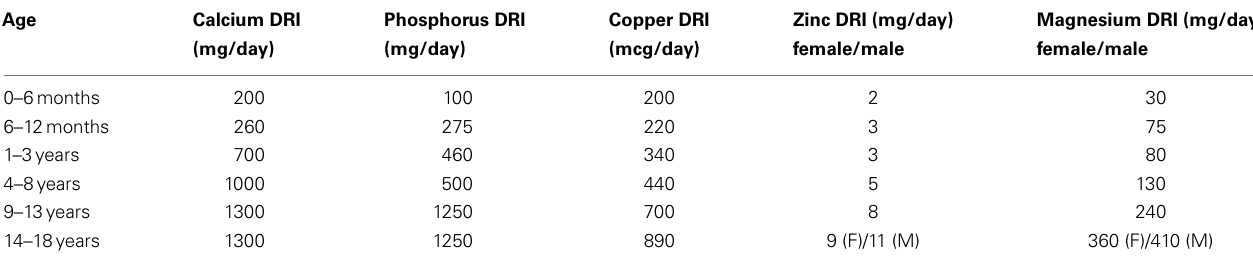
Table 1 | Dietary reference intakes (DRI) for calcium and phosphorus